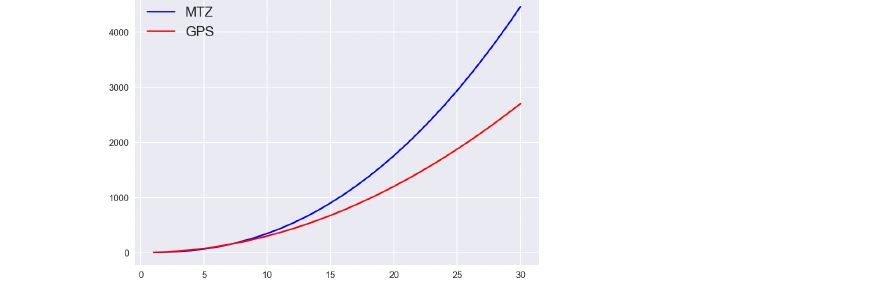
Figure 10. Benchmark between MTZ and GPS model based on the number of qubits. We can appreciate that for 30 cities, GPS model needs 2700 qubits while the MTZ